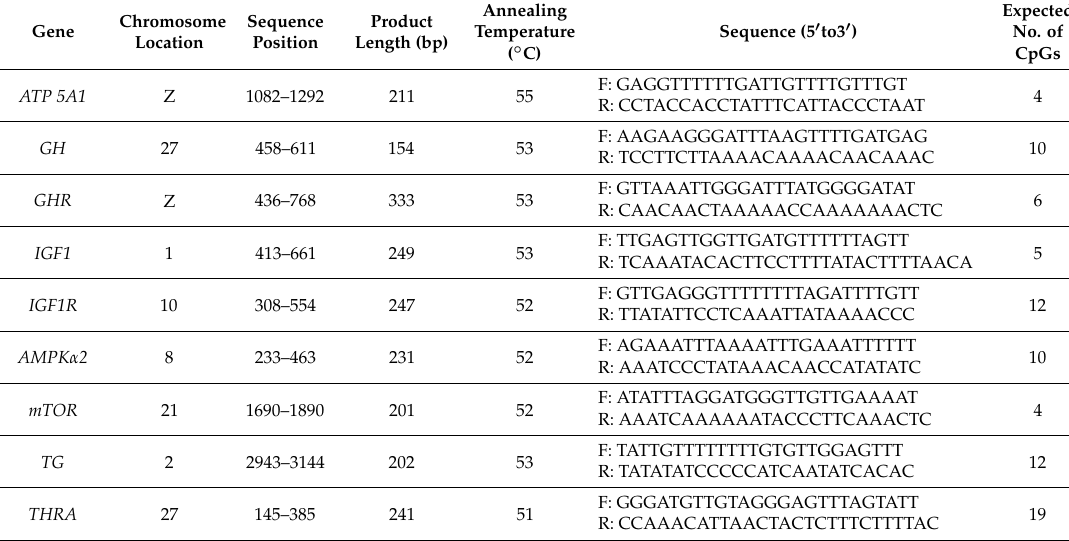
Table 4. Primer sequences for bisulfite-sequencing